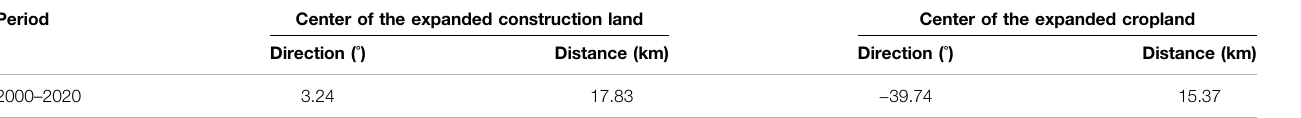
TABLE 3 | Moving directions and distances of the gravity centers of the expanded construction land and cropland. Period Center of the expanded construction